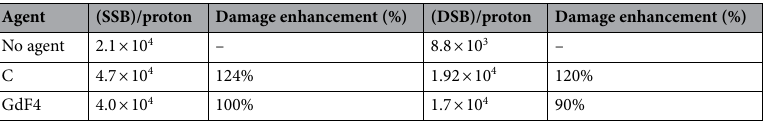
Table 4. The total numbers of SSB and DSB have been calculated according to the particle spectrum corresponding to without nano-target (no agent) and with one nano-target of C and GdF4. When one C nano- target is added, the SSB and DSB values increase to 124% and 120%, respectively. When one GdF4 nano-target is added, the resulted increases are 100% and 90%, respectively.